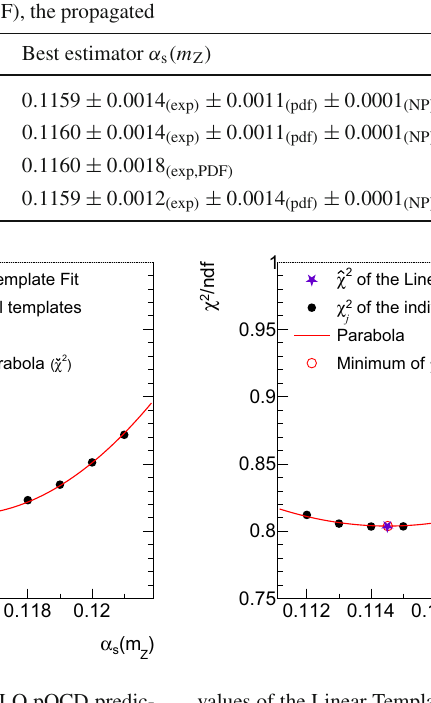
NP uncertainties (NP), and the last column shows the χ 2 / n dof values. ThedifferencebetweenthelinearandtheQuadraticTemplateFitisonly 0 . 000017, but appears larger due to a rounding effect. Differences to the CMS result may also be due to numerical limitations of the input data, or how the PDF uncertainties are symmetrized. The total uncertainties that are considered in the fit sum to ± 0 . 0018 in all cases